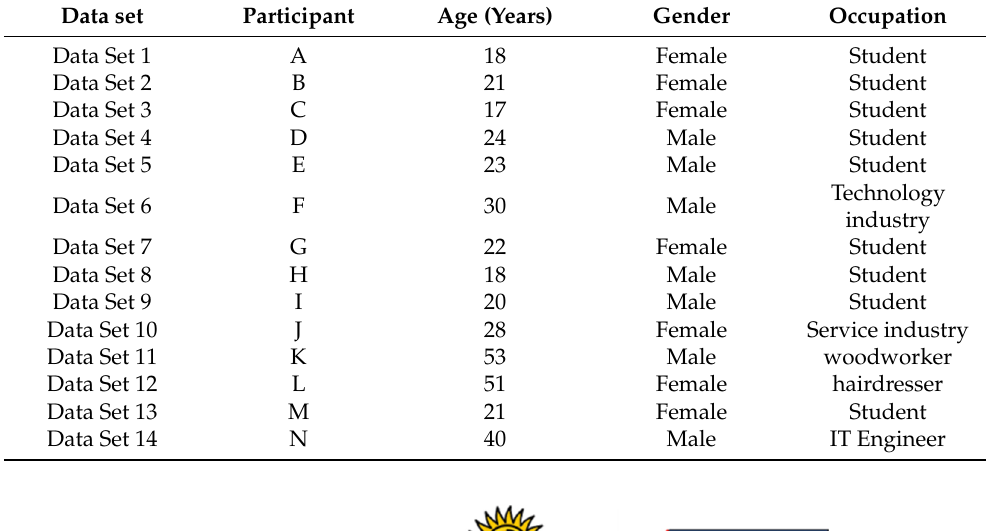
Table 3. Information on the data sets used in this study.